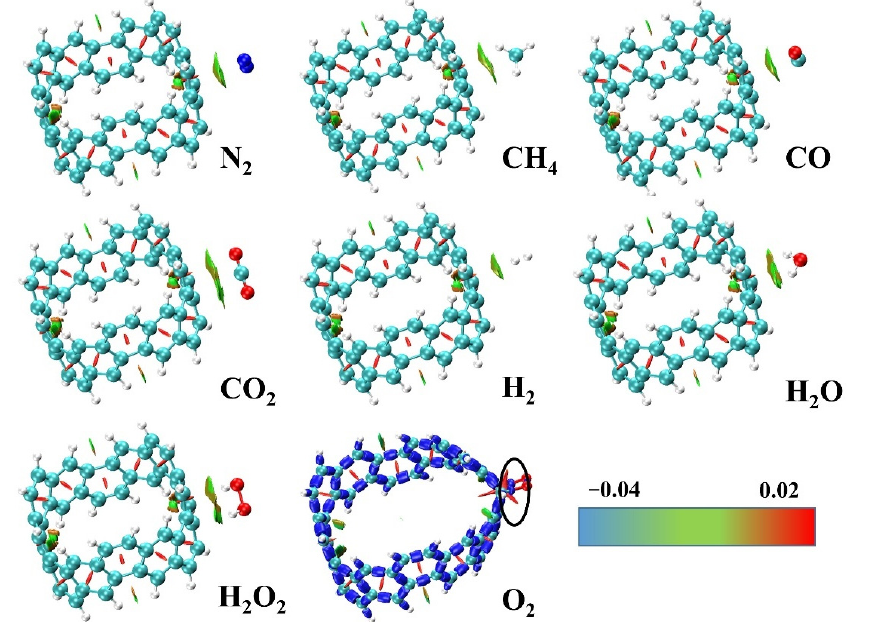
Figure 4. The optimized structure and RDG diagram (isovalue = 0.5) of small molecules adsorbed on the outside of [6, 6]CNB. Only [6, 6]CNB&O 2 (ext) use the Interaction Region Indicator (IRI) method. The surfaces between the [6, 6]CNB and the adsorbates correspond to the isosurface of RDG mapped by sign ( λ _2 ) ρ function, in a.u.